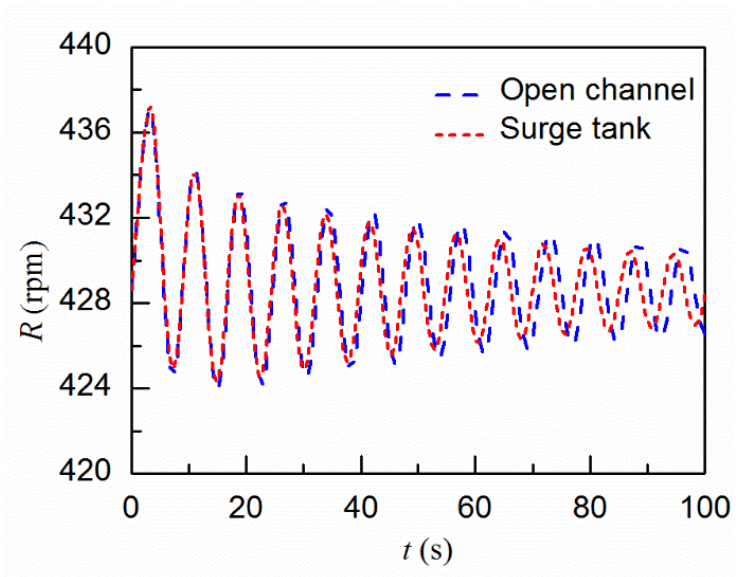
Figure 16. Comparison of the turbine rotational speed with different modelling methods ( L 1 = 2000 m, h = 10 m, w = 10 m).